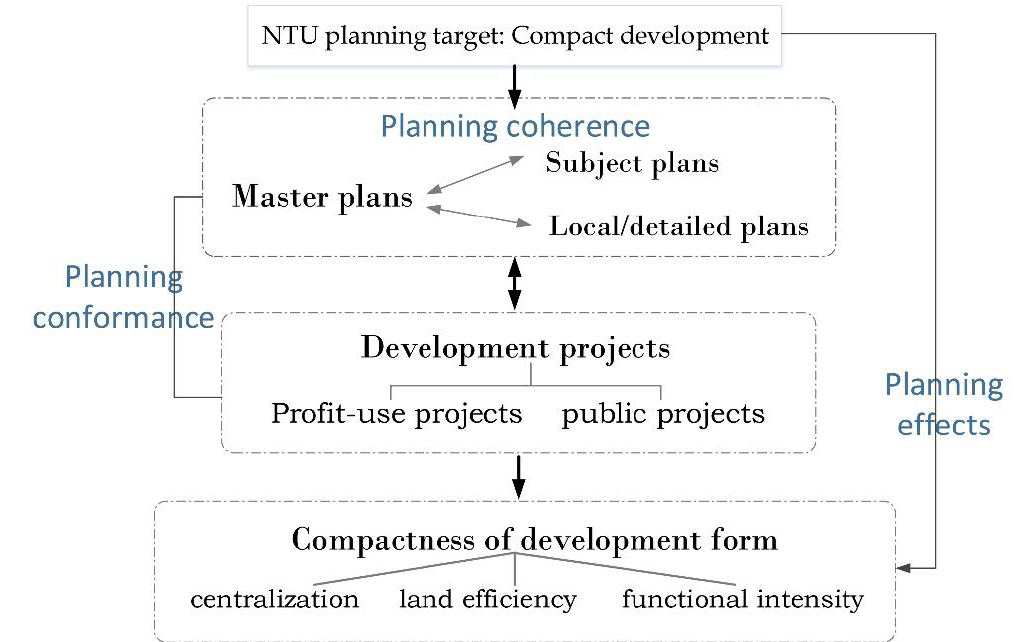
Figure 2. Research design.